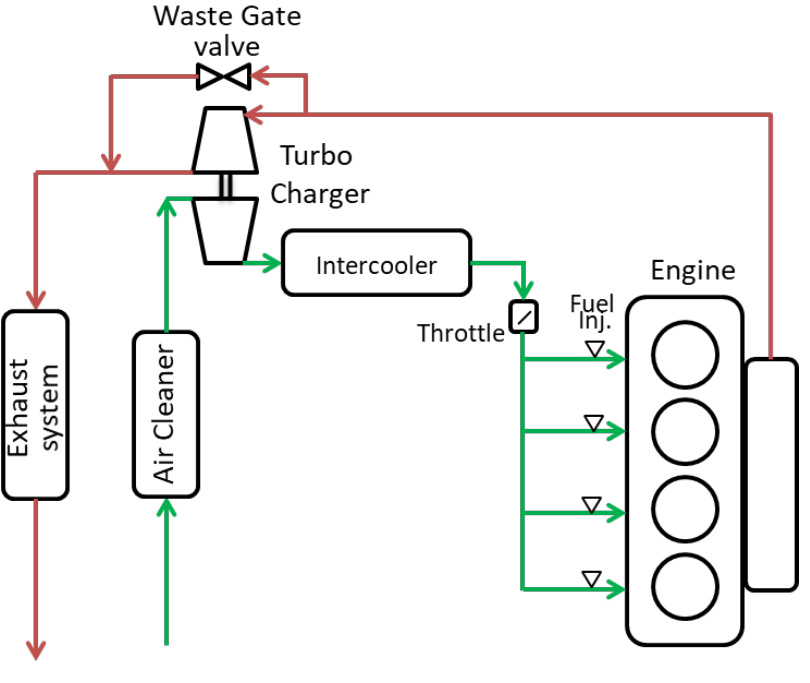
Figure 2. Schematic of engine layout.